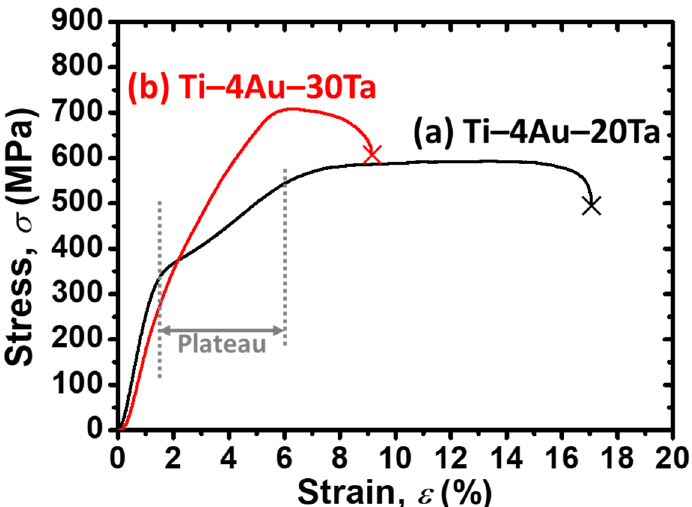
Figure 4. Stress–strain (SS) curves of the ( a ) Ti–4Au–20Ta alloy and the ( b ) Ti–4Au–30Ta alloy via the continuous tensile tests. The cross symbols at the end of the curves suggest fractures of the specimens. A stress plateau in the ( a ) Ti–4Au–20Ta alloy was indicated by the vertical dashed lines and the horizontal solid arrows.